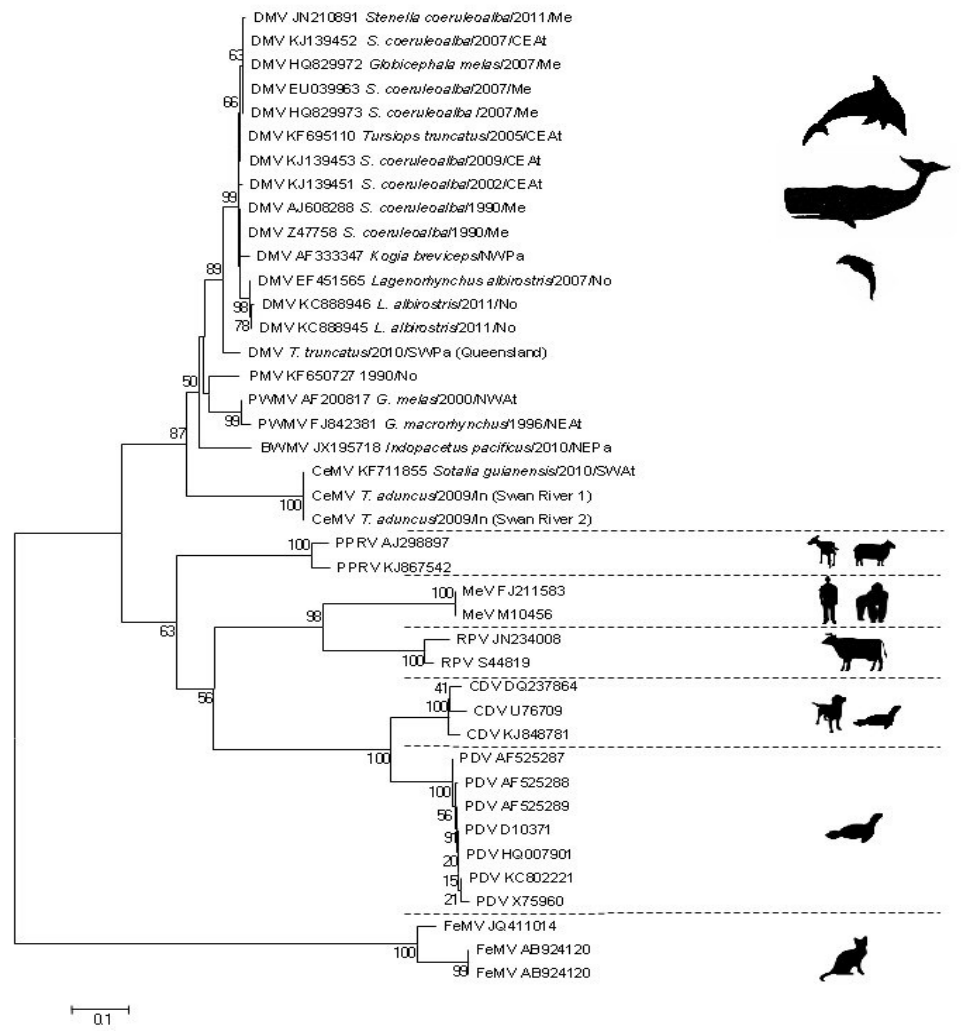
Figure 2. Phylogenetic analysis of a fragment of the morbillivirus P gene. Sequences were trimmed to include all sequence data available. Each sequence is denoted by its accession number (where available) and strain/isolate details (cetacean species, and year and geographic area of stranding). The evolutionary history of the isolates assessed was inferred using the neighbour-joining method with branch lengths in the same units as those of the evolutionary distances used to infer the phylogenetic tree. The evolutionary distances were computed using the Kimura 2-parameter method and are in the units of the number of base substitutions per site detailed with bootstrap values of >50 being shown against key nodes. The phylogeny includes 41 nucleotide sequences with a total of 253 positions in the final dataset. Evolutionary analyses were conducted in MEGA5 [35]. Abbreviations are: BWMV, beaked whale morbillivirus, DMV, dolphin morbillivirus; CeMV, cetacean morbillivirus; PMV, porpoise morbillivirus; PWMV, pilot whale morbillivirus; PPRV, peste-des-petits-ruminants virus; RPV; rinderpest virus; CDV, canine distemper virus; PDV, phocine distemper virus; MeV, measles virus; NEAt, Northeastern Atlantic Ocean; CEAt, Central Eastern Atlantic Ocean; NWAt, Northwest Atlantic Ocean; SWAt, Southwest Atlantic Ocean; Me, Mediterranean Sea; No, North Sea; NEPa, Northeastern Pacific Ocean; NWPa, Northwest Pacific Ocean; SWPa, Southwest Pacific Ocean; In, Indian